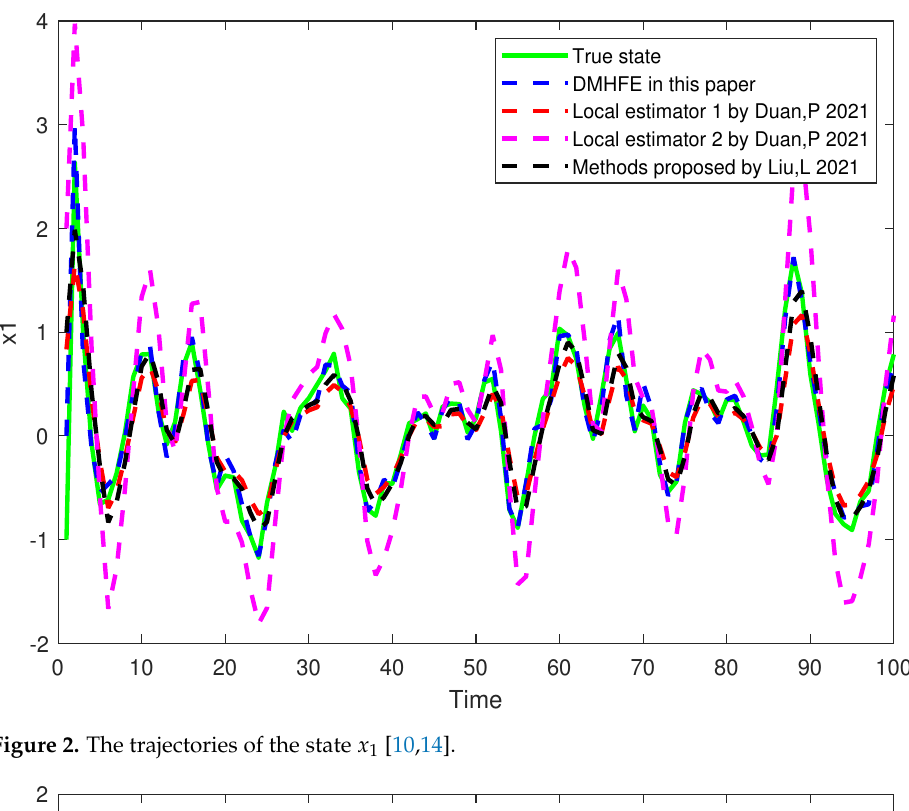
Figure 2. The trajectories of the state x 1 [10,14].